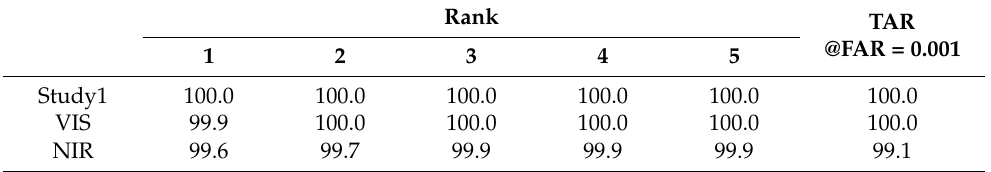
Table 11. Results (in %) achieved in the face recognition task, using the CASIA NIR-VIS 2.0 database.